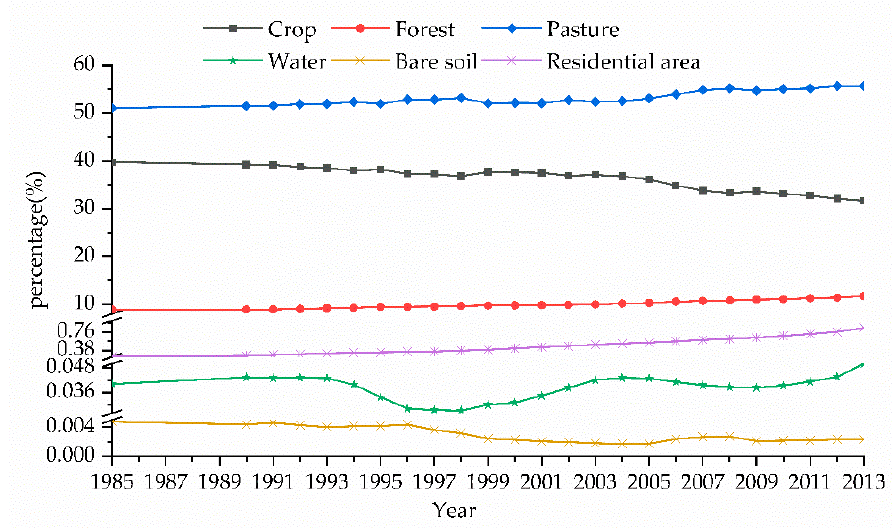
Figure 9. Change in the proportion of the six land use types, from 1985 to 2013.